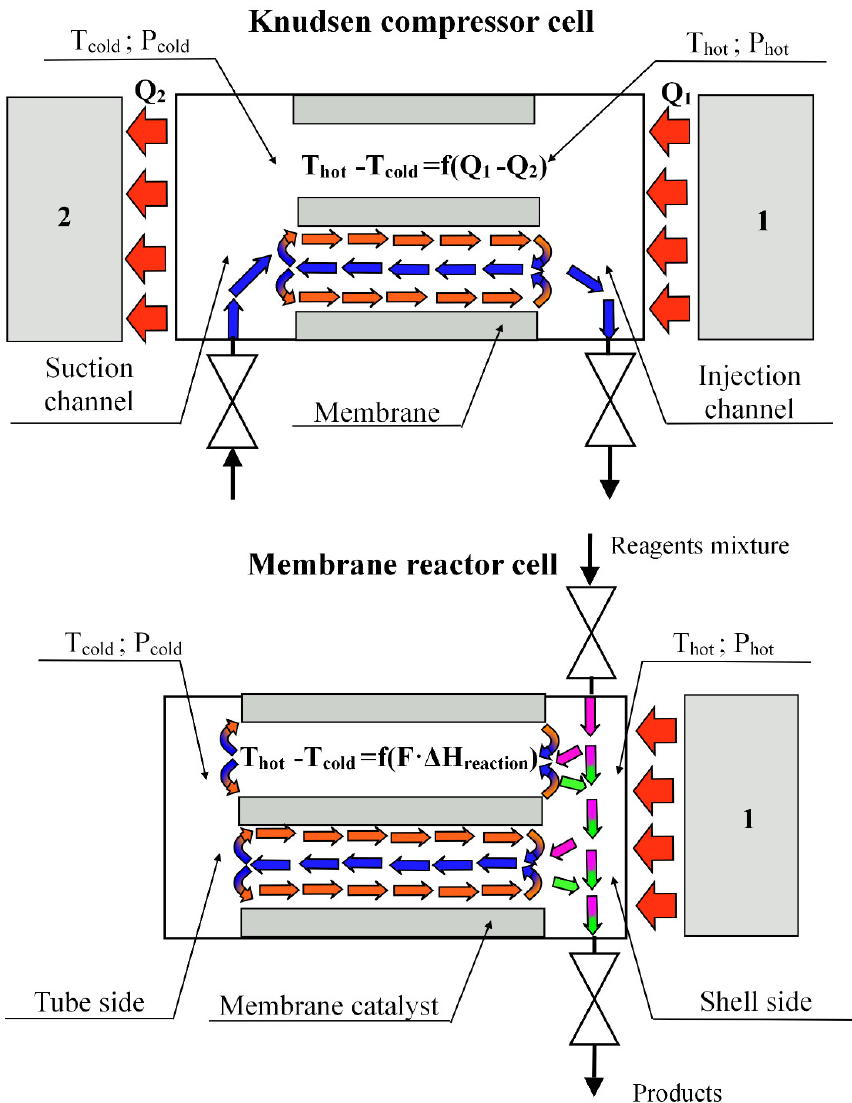
Figure 8. Constructive analogy and flow diagram in a Knudsen compressor and a reactor with a membrane catalyst (cross-section near diaphragm): 1—heater, 2—cooler. F i —mole flow of component, which takes part in the endothermic reaction; ∆ H reaction —heat effect of reaction. Mass flows in the shell side: pink arrows—reagents mixture, green arrows—products of DRM; circulation loop: orange arrows—thermal slip flow; blue arrows—viscous flow. Thermal flow—red arrows.